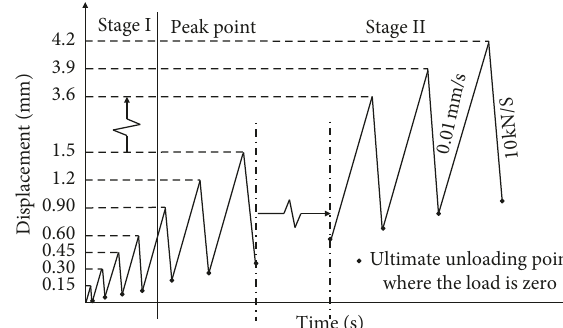
Figure 4: Schematic diagram of cyclic loading procedure [37].